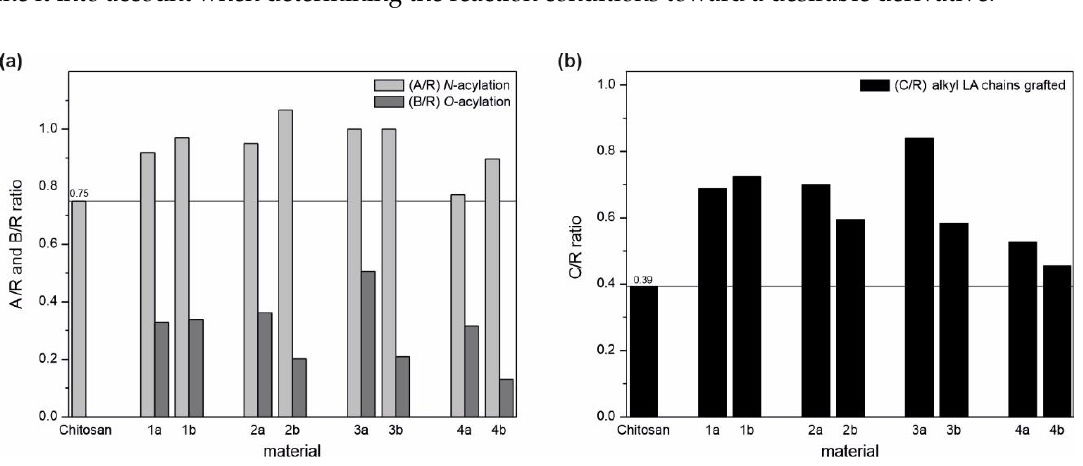
Figure 2. Relative amount of ( a ) amide ( N -acylation), ester ( O -acylation) and ( b ) alkyl groups represented by bands ratio.